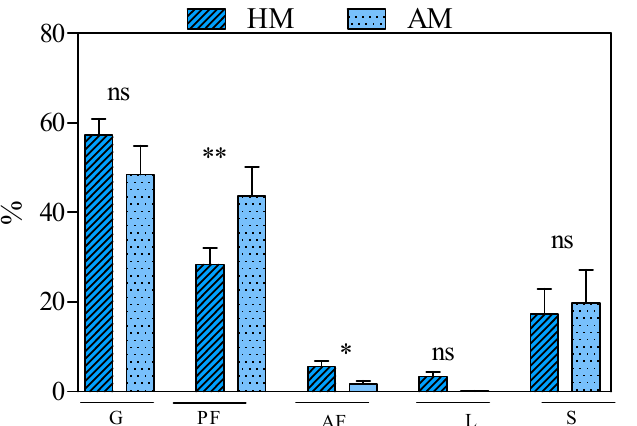
Figure 3. Plant functional type composition (% PTF) in hay (HM) and abandoned (AM) meadow, as the ratio of the percentage canopy cover of each PFT to the total canopy cover of all the PFTs recorded. G = graminoid; PF = perennial forbs; L = legumes; AF = annual forbs; S = shrubs. Data are means of 16 samples ± SE. Asterisks represent significance of p < 0.05; * = p < 0.05; ** = p < 0.01; ns = not significant.